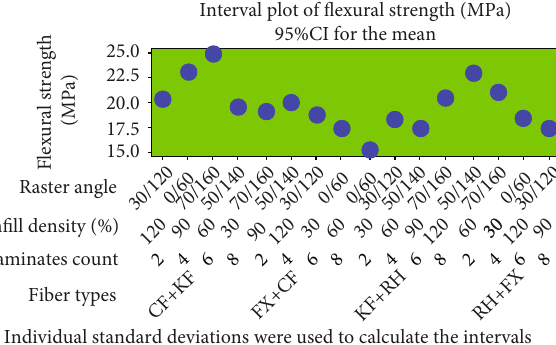
Figure 6: Interval plot of fl exural strength.